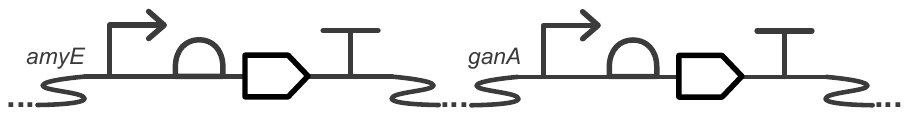
Figure 44: Two functional units, one integrated into the amyE locus, another integrated into the ganA locus.